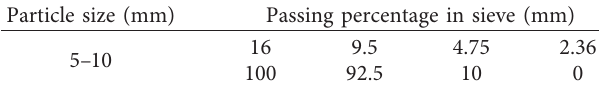
Table 1: Gradation of